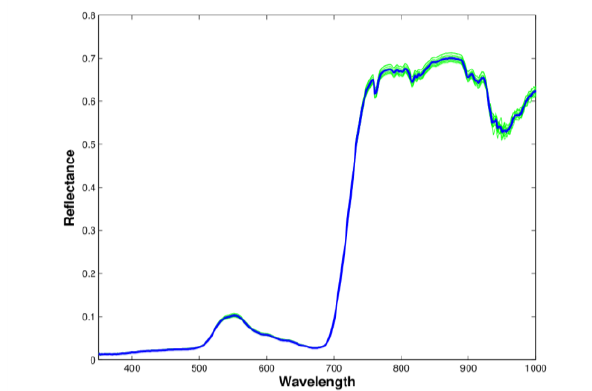
Figure 3. Reflectance spectra’s of water hyacinth over the Tapi River, blue color represents the mean spectra